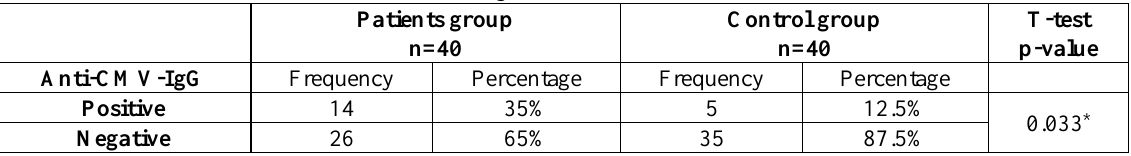
Table 3: Prevalence of Anti-CMV IgG Antibodies in Saliva of Patients and Controls.